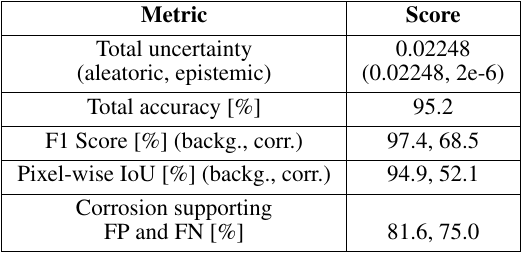
Table 2. Results of Deeplab V3+ segmentation network trained on 70 % weakly supervised images with respect to test set Metric Score Total uncertainty 0.02248 (aleatoric, epistemic) (0.02248, 2e-6) Total accuracy [%] 95.2 F1 Score [%] (backg., corr.) 97.4, 68.5 Pixel-wise IoU [%] (backg., corr.) 94.9, 52.1 Corrosion supporting FP and FN [%] 81.6, 75.0